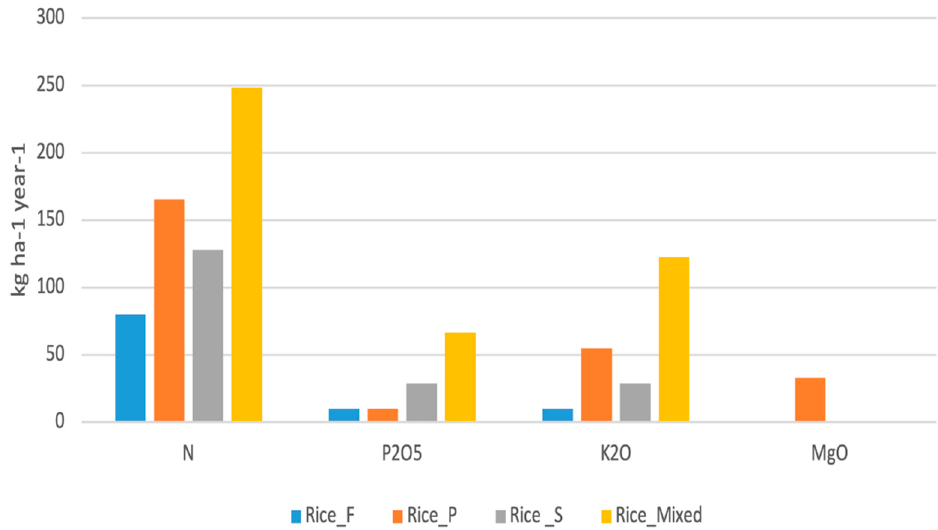
Figure 2. Synthetic fertilizers applied annually for each RRCS. Note: The information is obtained from observations and surveys of each rice-growing area.